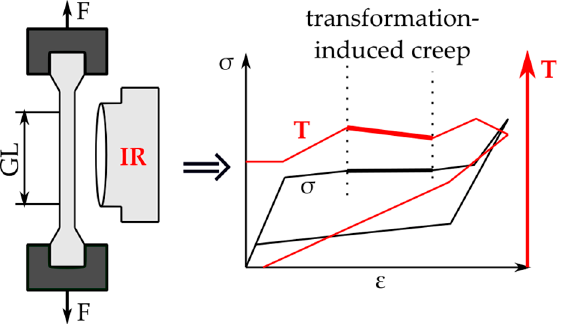
Figure 1. Scheme of the experimental set-up applied for transformation-induced creep-like phenomena in shape memory alloy (SMA).